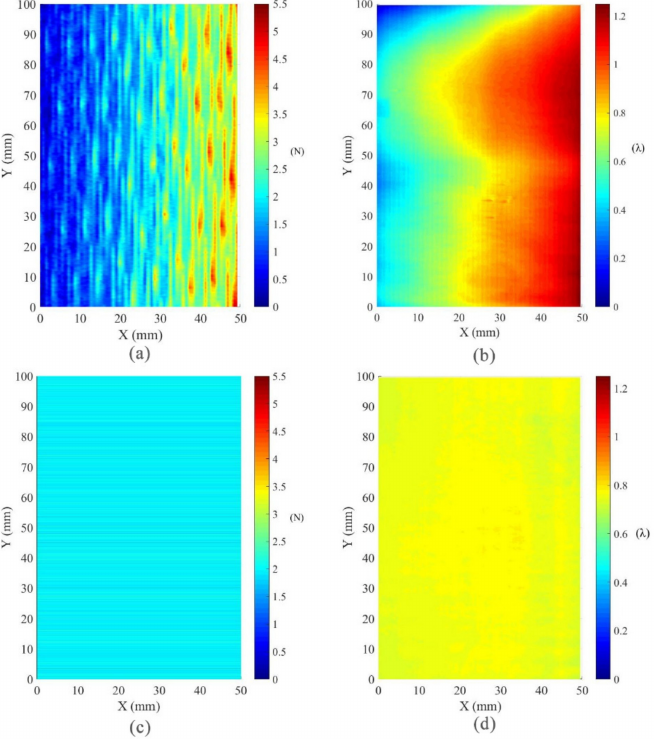
Figure 13. The normal force distribution and removal amount distribution with/without constant force control: ( a ) Normal force distribution of MRF process without constant force control; ( b ) The removal amount distribution without constant force control; ( c ) Normal force of MRF process with constant force control; ( d ) The removal amount distribution with constant force